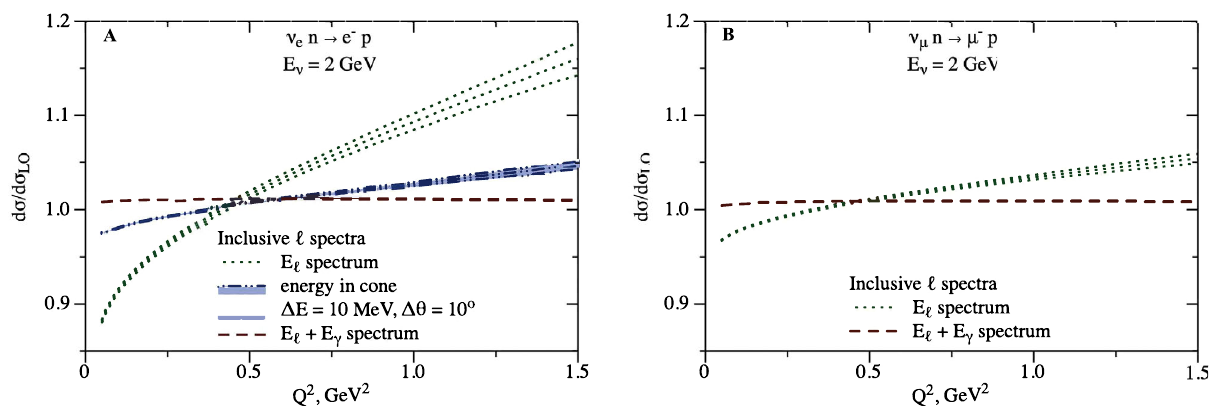
Fig. 4 | Radiatively corrected cross-section ratio to the tree-level result and corresponding uncertainty in neutrino scattering for inclusive observables.